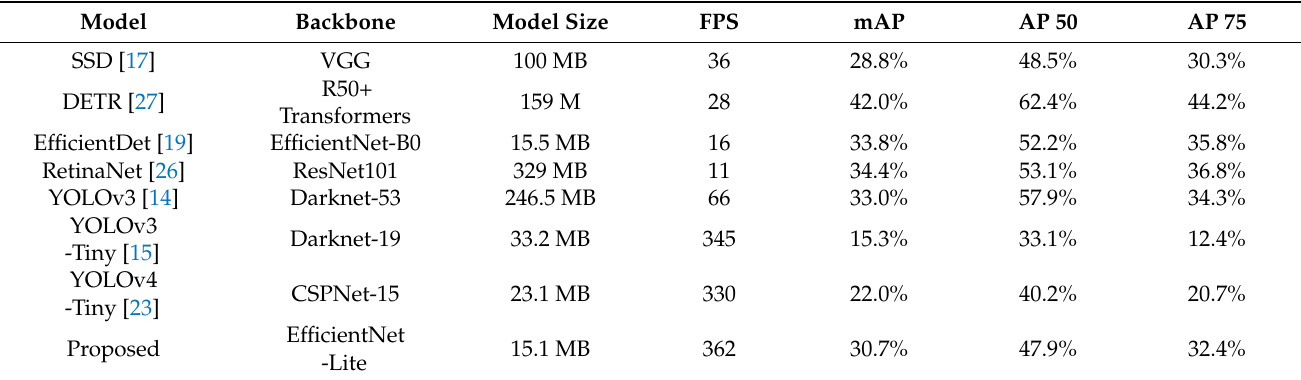
Table 1. Comparison among the state-of-the-art detectors.